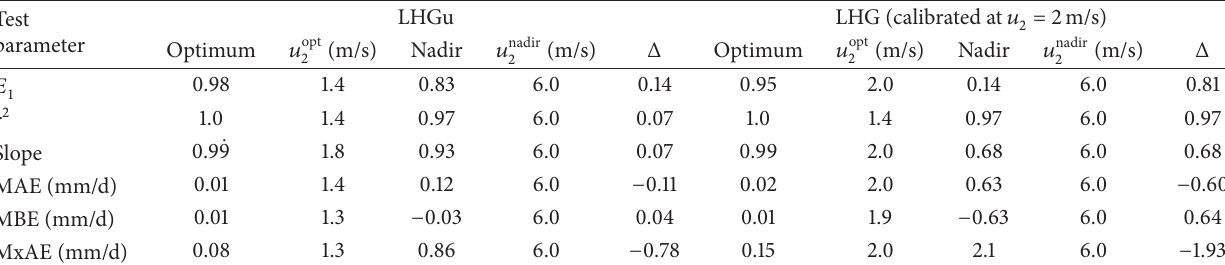
Table 2: Numerical highlights of Figure 3; Δ = Optimum − Nadir value of the test parameter.